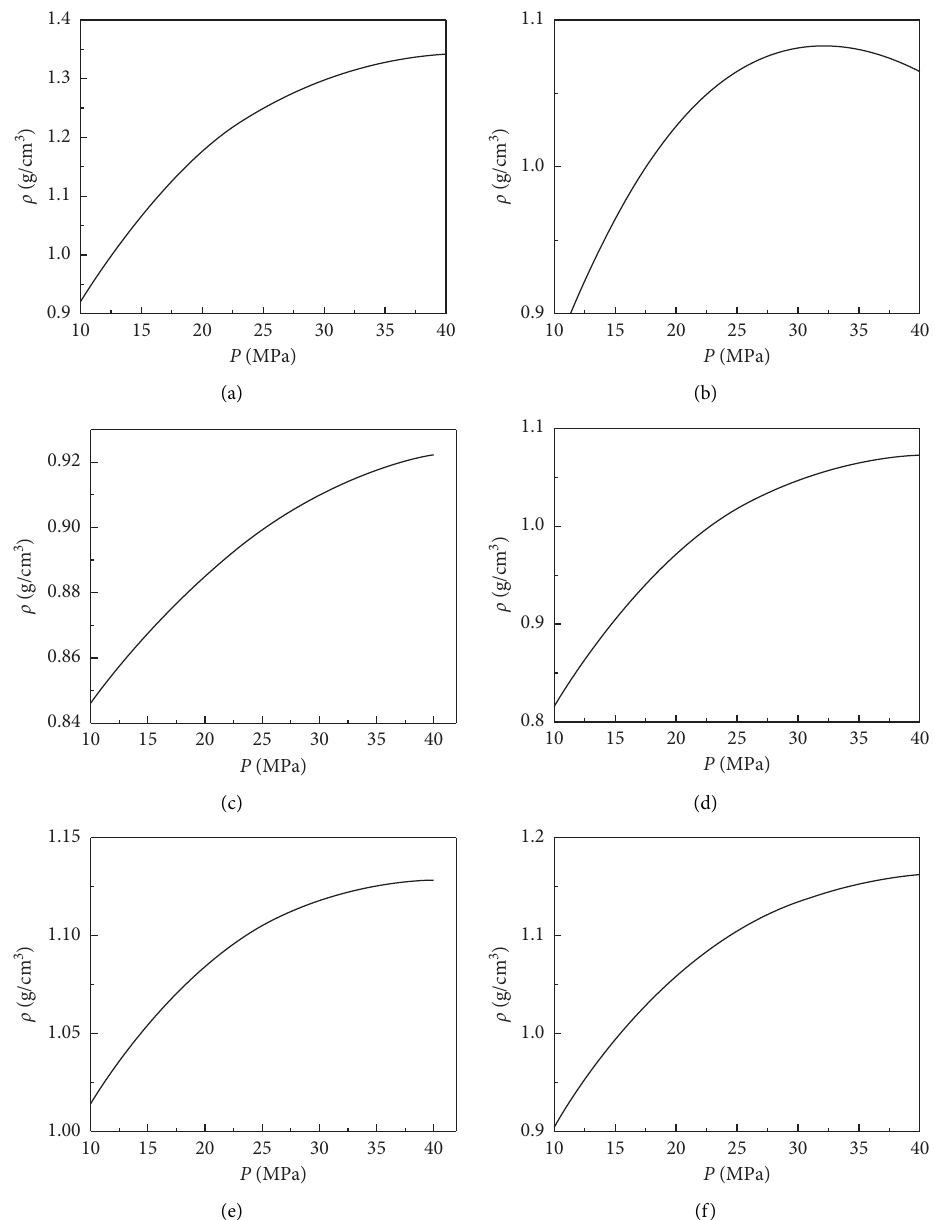
Figure 1: Density-pressure fitting curve. (a) Beanstalk. (b) Sawdust. (c) Wood shavings. (d) Arundo donax . (e) Acacia branches. (f) Average (above five